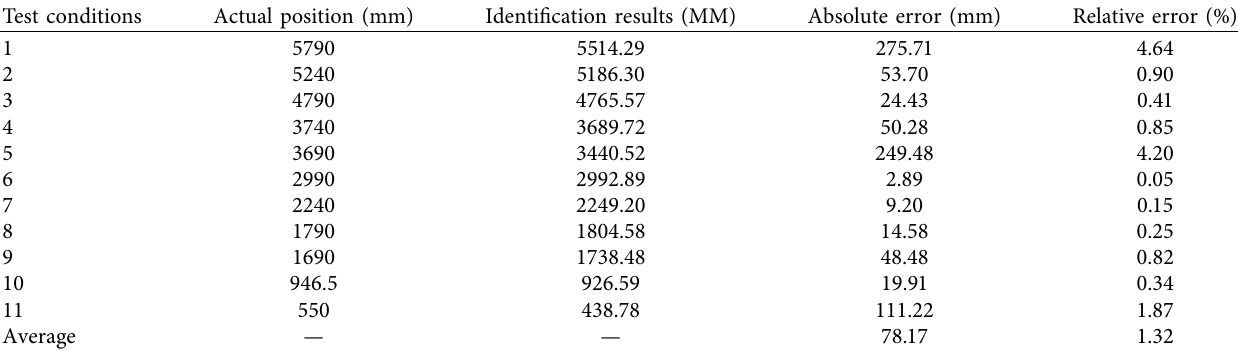
Table 7: Location results of the BP neural network without noise.